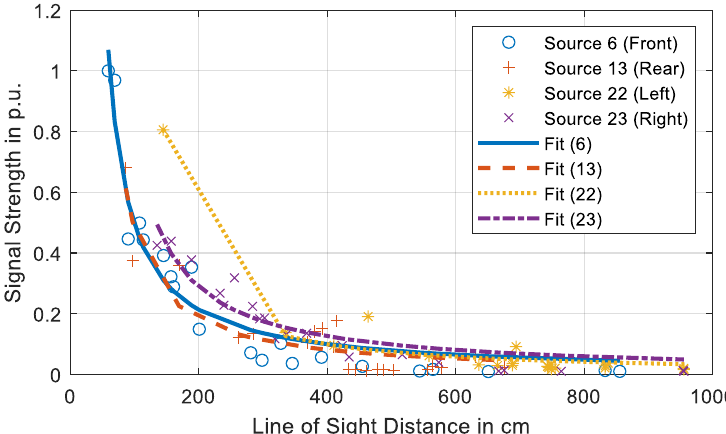
Figure 8. Comparison of attenuation of signals received from the individual sources.